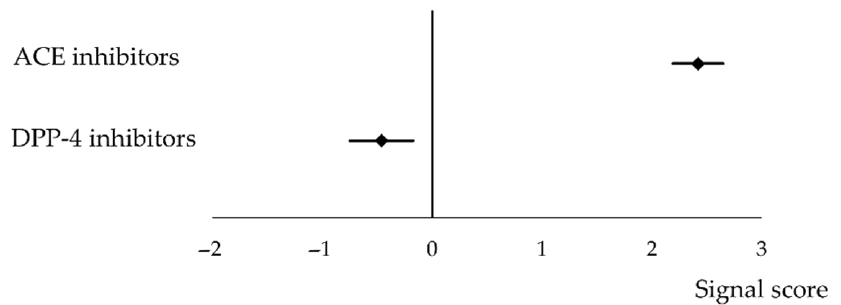
Figure 3. The signal scores of angiotensin-converting enzyme inhibitor and dipeptidyl peptidase-4 inhibitor-induced angioedema.